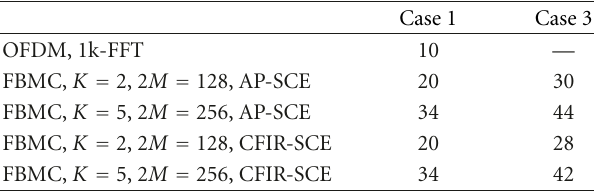
Figure 13: SIR due to frequency o ff set in OFDM and FBMC. Table 1: Multiplications in receiver per one detected complex sym- bol in OFDM and per two detected real symbols in